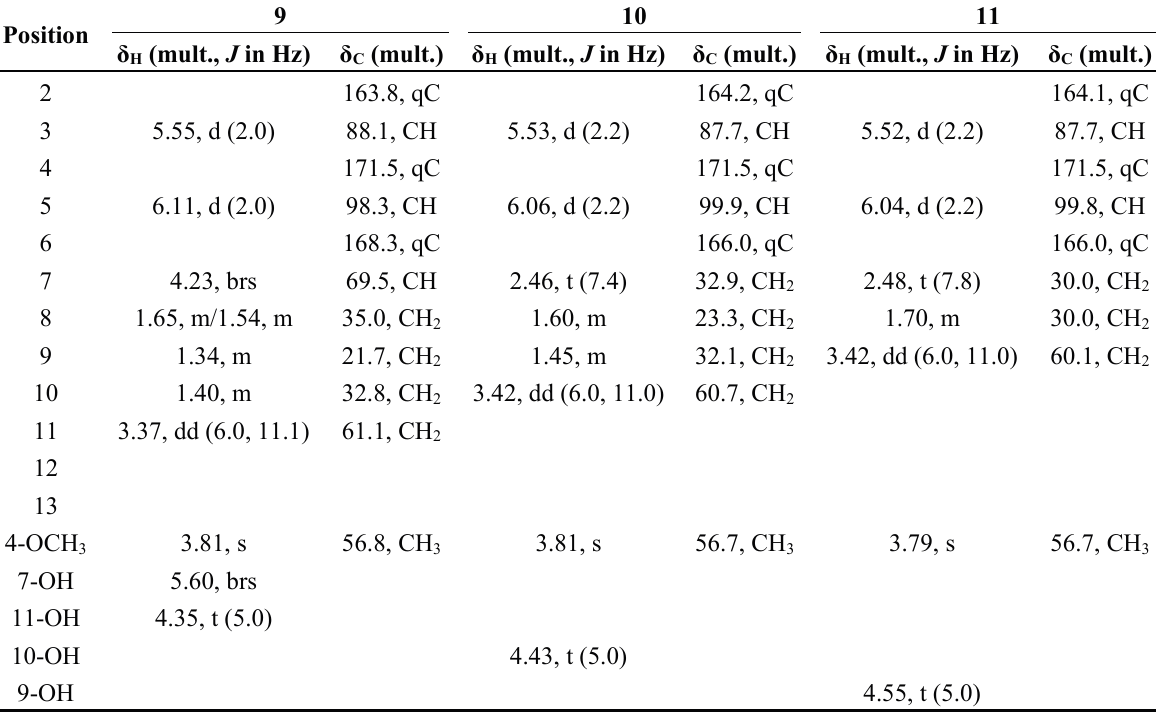
Table 2. 1 H- and 13 C-NMR spectral data (400 MHz, DMSO- d 6 ) of compounds 9 – 11 .